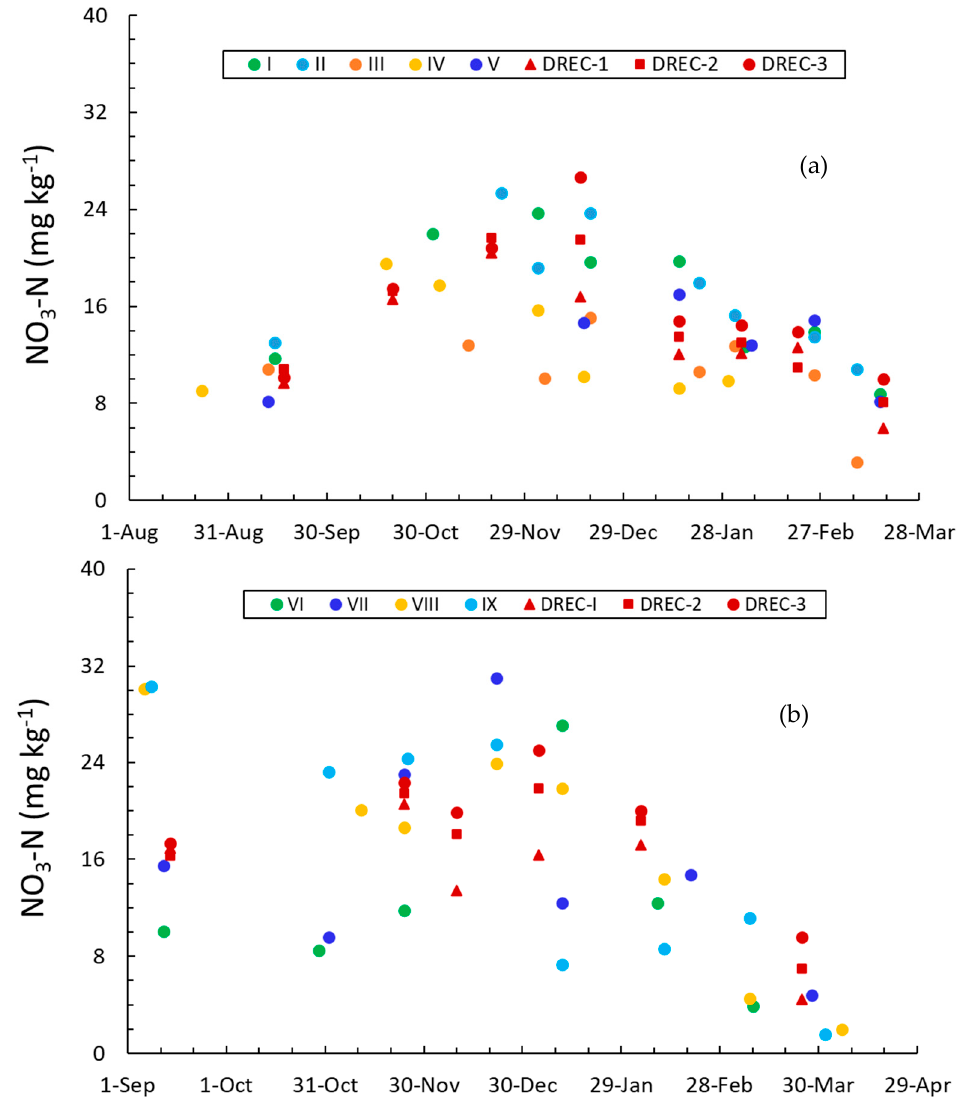
Figure 8. Soil nitrate-N (NO 3 -N) concentrations at the depth of 0–30 cm at the experimental sites over the 2019/2020 ( a ) and 2020/2021 ( b ) growing seasons.